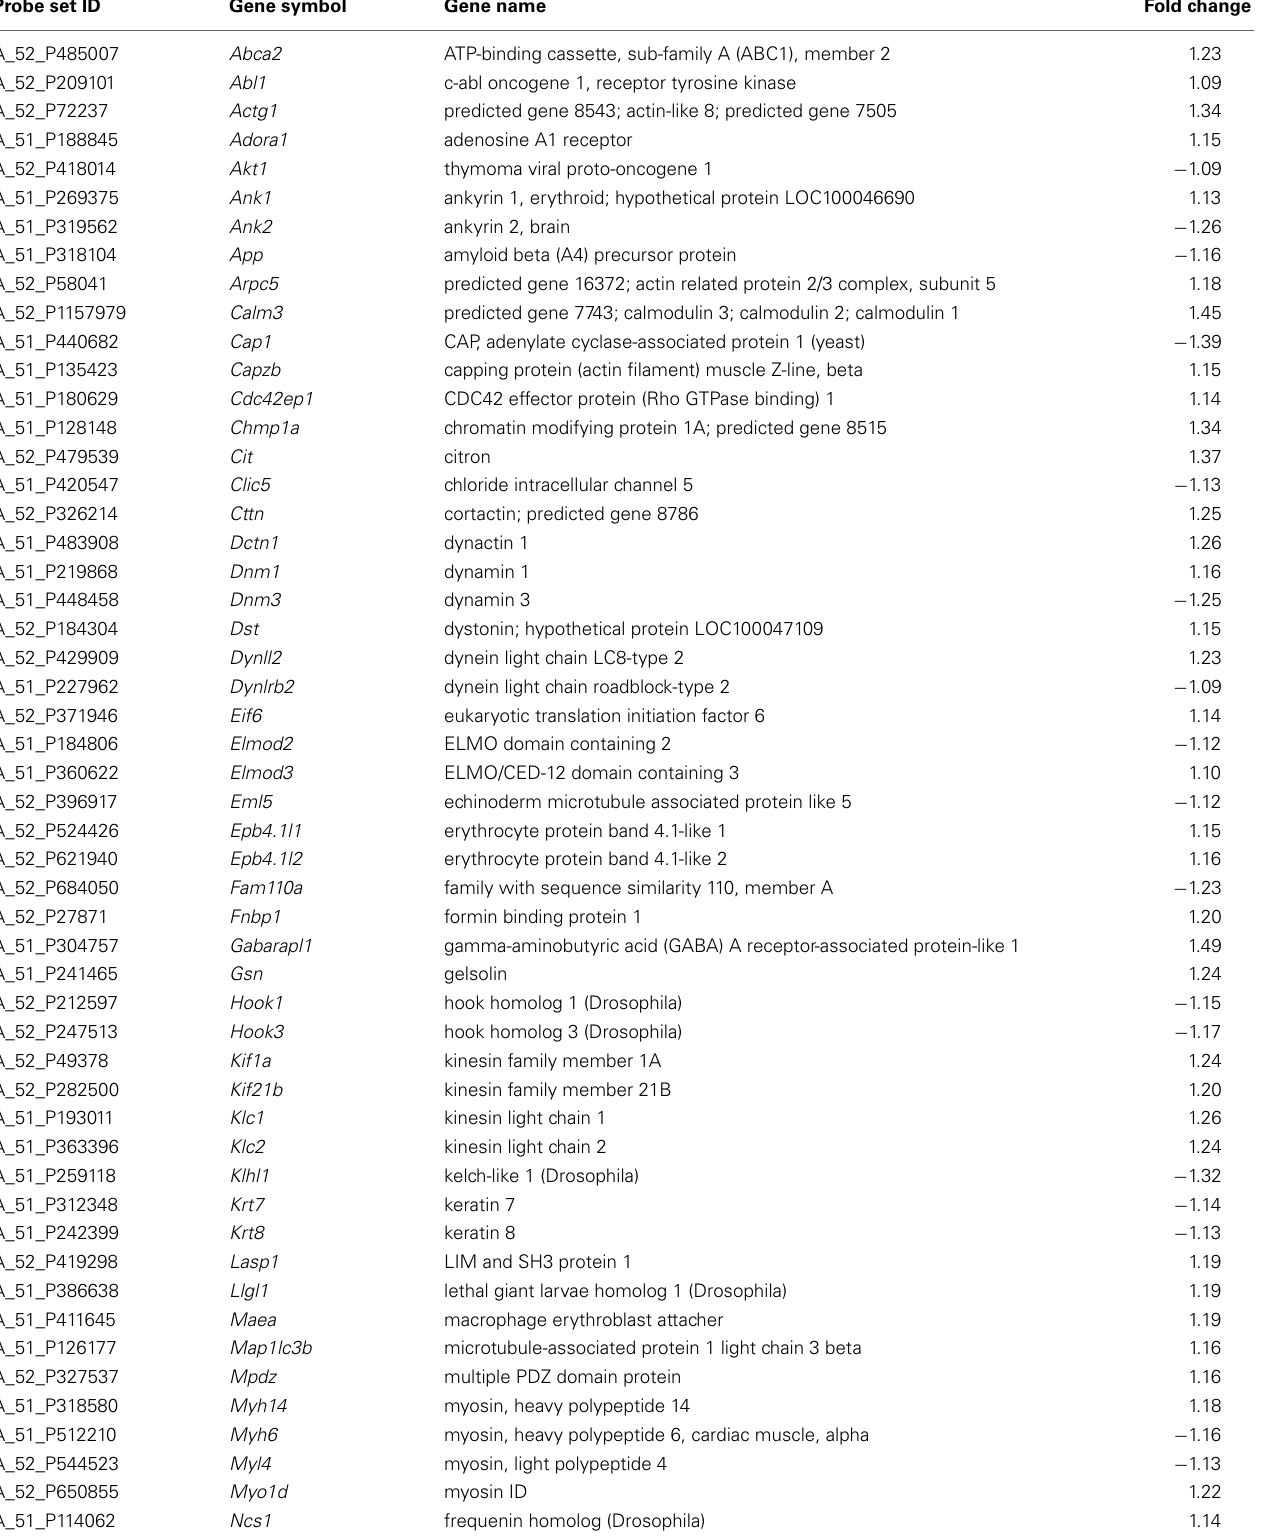
Table 2 | List of differentially expressed genes in spinal cord of 80 days old SOD1 G93A mice related to cytoskeleton. Probe set